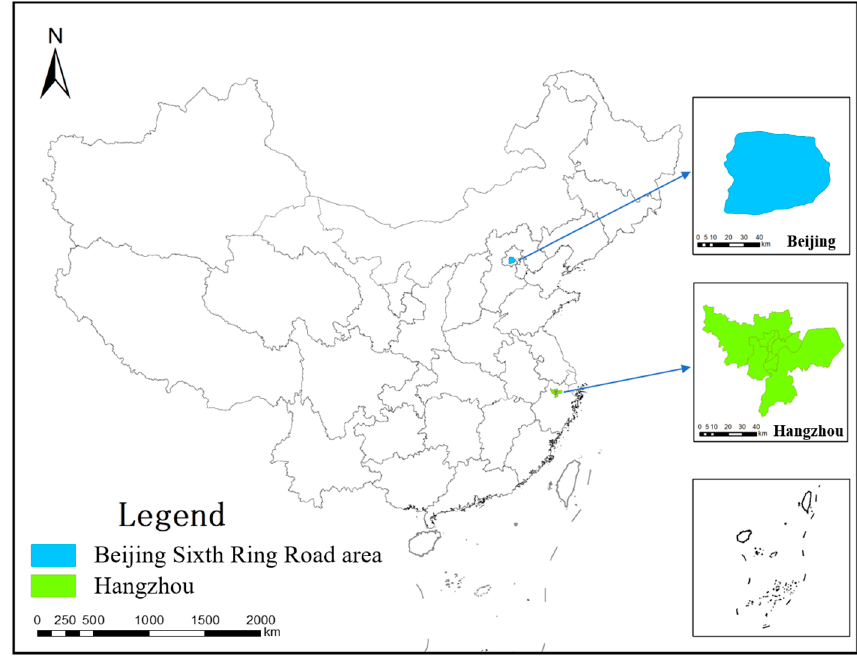
Figure 2. The study area of Beijing and Hangzhou, China.